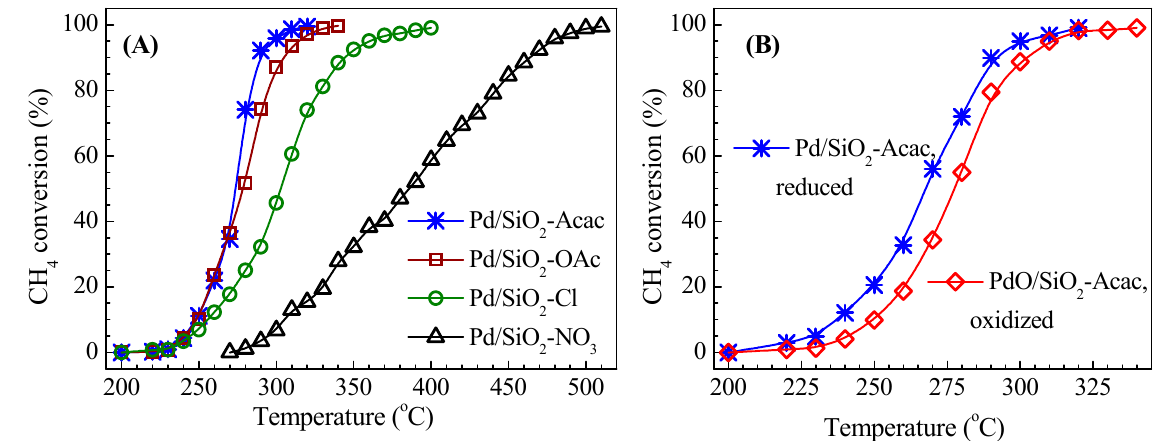
Figure 3. ( A ) A comparison of the Pd/SiO 2 - R catalysts prepared by the dry ball-milling method with different Pd precursors in their activity for lean methane oxidation. After the dry ball-milling, the Pd/SiO 2 - R catalysts were calcined in air at 400 ◦ C for 4 h and then reduced with hydrogen at 400 ◦ C for 1 h. ( B ) A comparison of the Pd/SiO 2 -Acac (reduced) and the PdO/SiO 2 -Acac (oxidized) catalysts of different Pd oxidation states in their activity for lean methane oxidation. The light-off reaction tests were conducted with the feed of 1 vol.% CH 4 and 99 vol.% air and a GHSV of 30,000 mL h − 1 g − 1 .